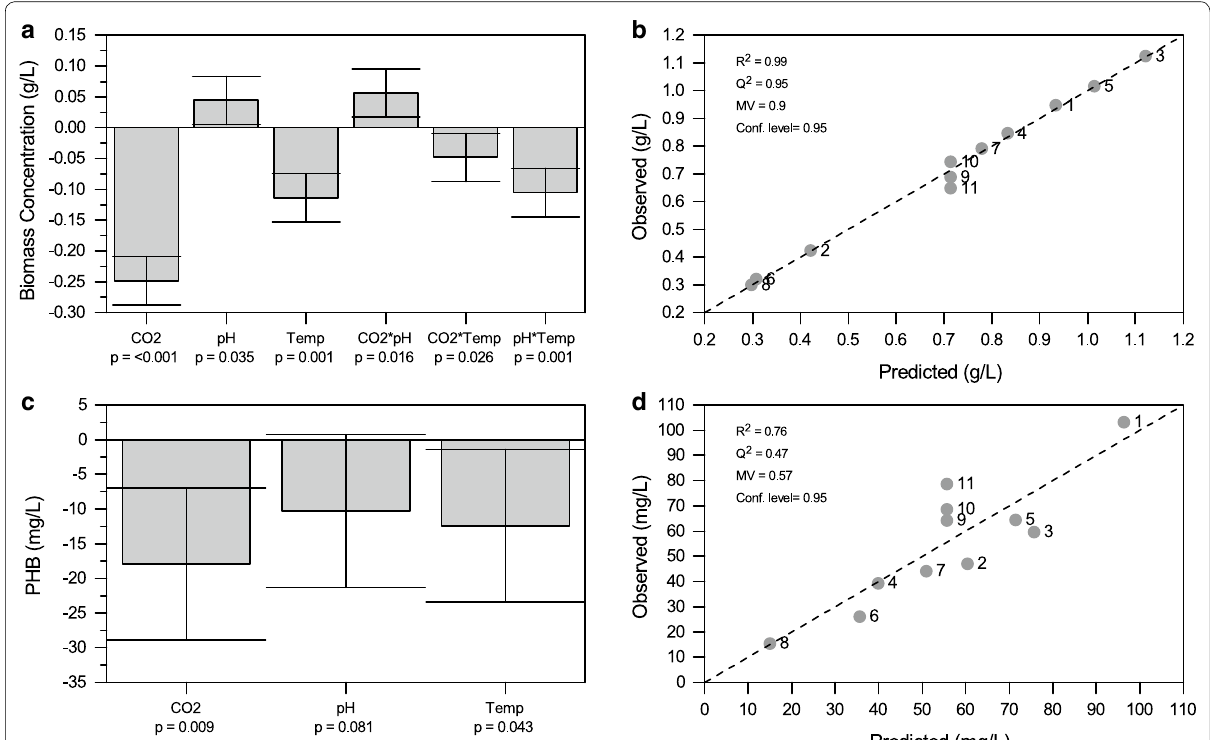
Fig. 2 a , c Represent the coefficient plots of the DoE experiments for Synechocystis sp. PCC 6714 under nitrogen and phosphorus limitation, for biomass concentration ( a ) and PHB accumulation ( c ), respectively. b , d Show the model parameters and observed-versus-predicted plots of the models obtained for biomass concentration ( b ) and PHB accumulation ( d ) under nitrogen and phosphorus